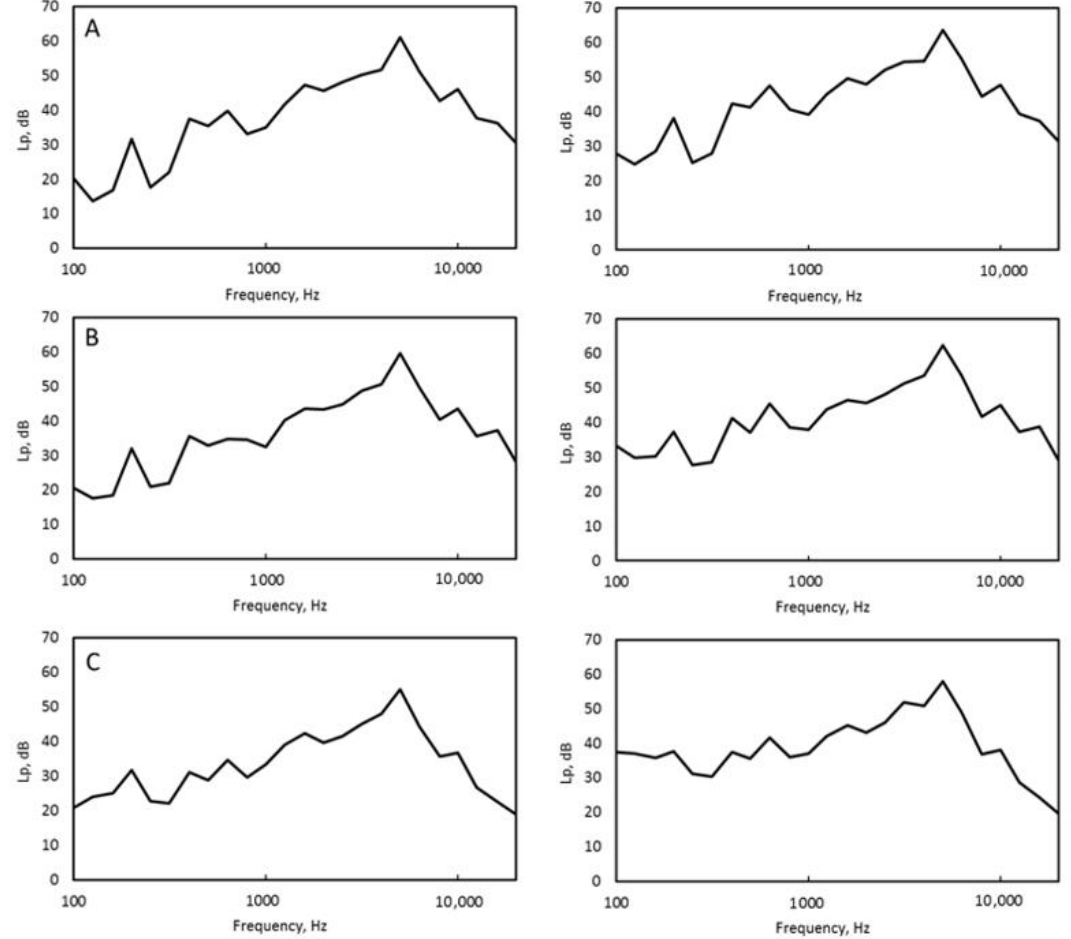
Figure 4. Values of the minimum (at the left) and average (at the right) spectrum emitted in the position of the UAV in the environment under test, in absence of noise. The receiver–source distances are respectively: (( A ) equals 5 m, ( B ) equals 10 m, and ( C ) equals 15 m).